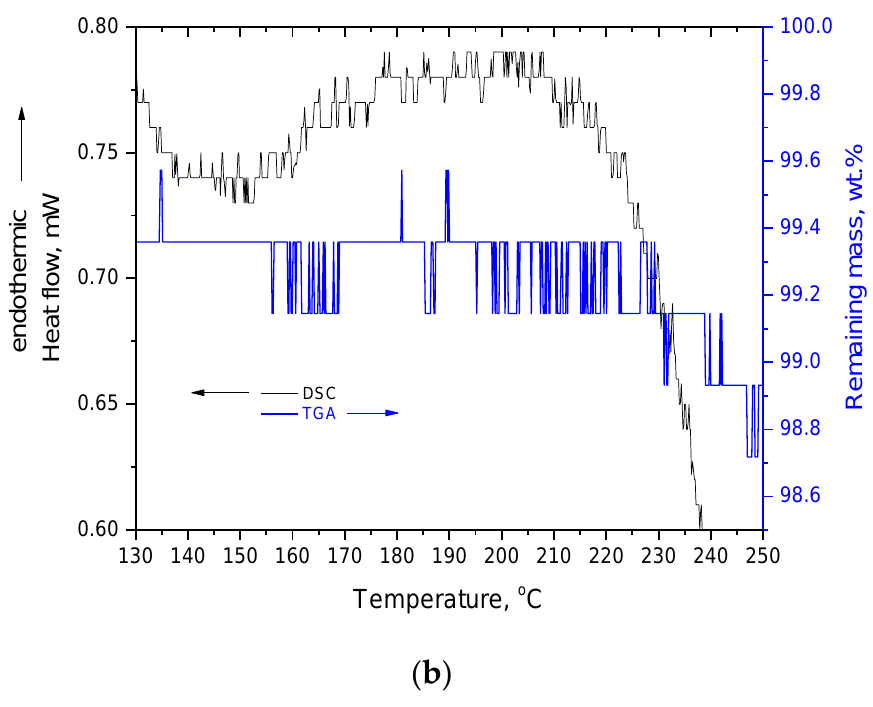
Figure 1. DSC and TGA curves of quercetin: ( a ) in the temperature range 50 – 350 °C, and ( b ) under different scale in the Y-axes and in the temperature range 130 – 250 °C.